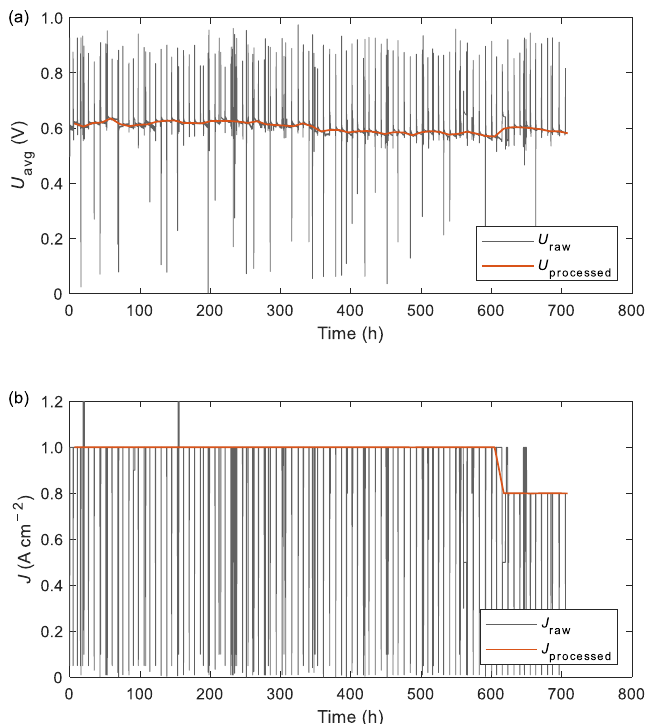
Figure 2. Average voltage ( a ) and current density ( b ) of PEMFCs stack over time.